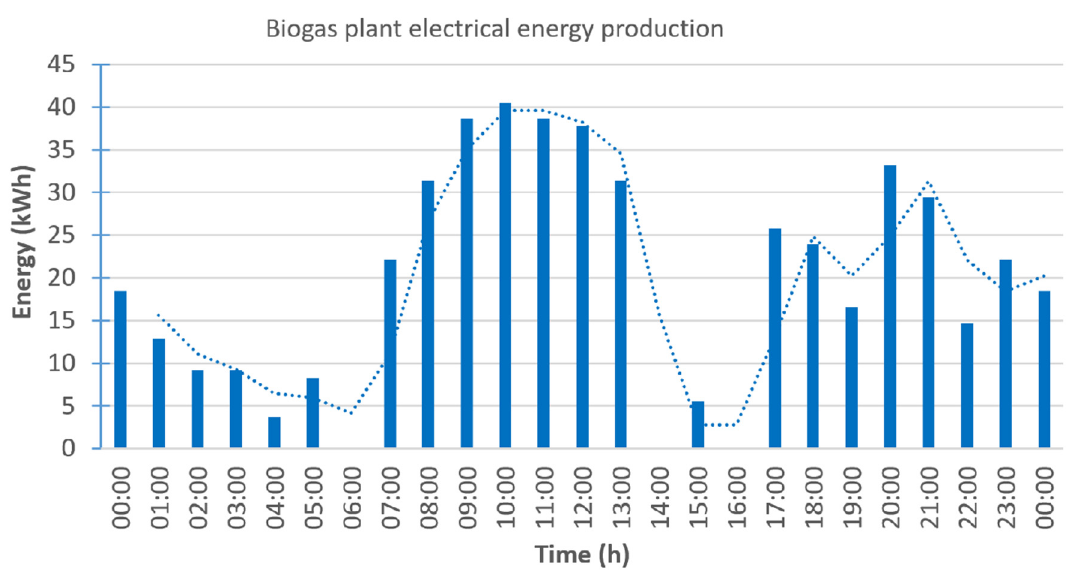
Figure 6. Biogas plant’s electrical energy production profile during a 24 h cycle for farmland with 20 cows. Own study based on source [55].